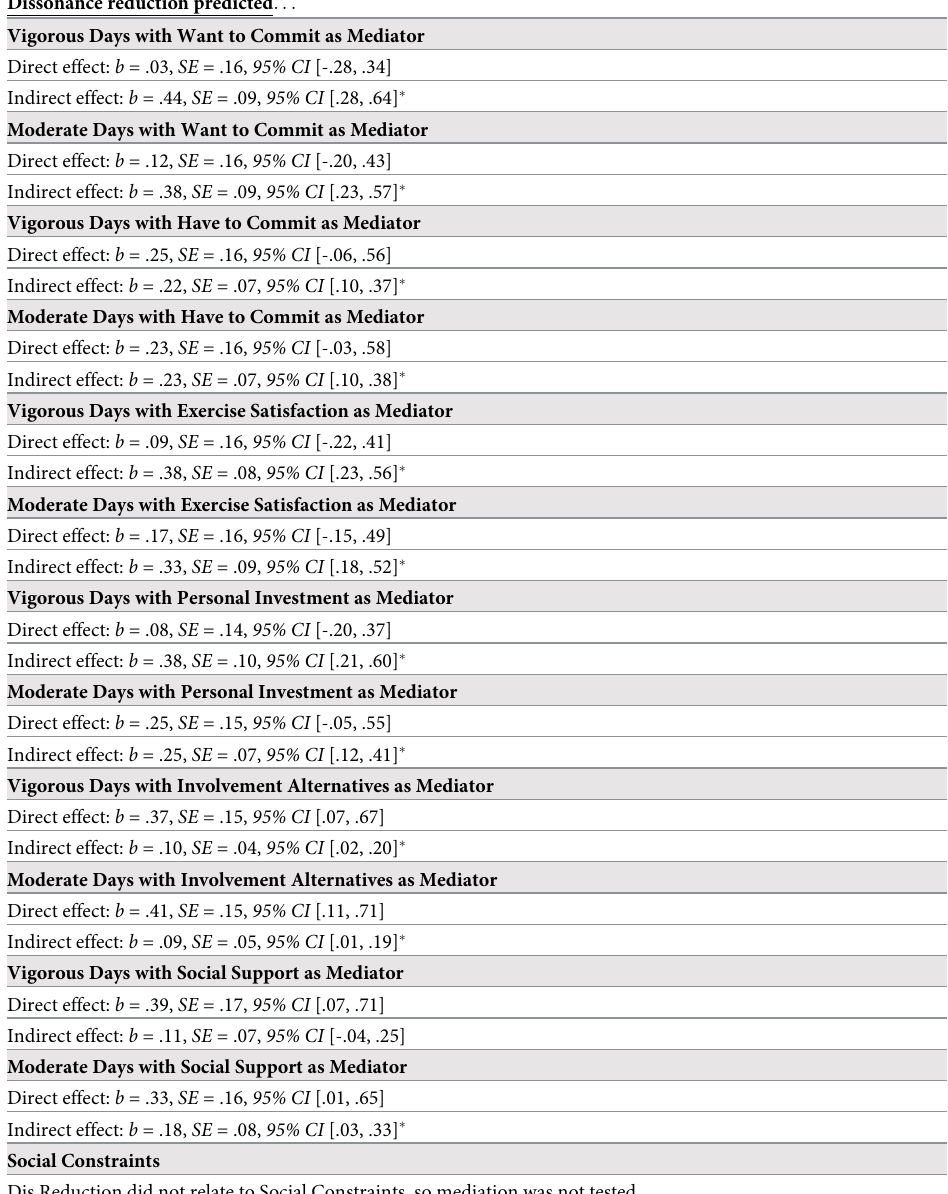
Table 12. Mediational analyses for dissonance reduction and days of exercise (Study 2). Dissonance reduction predicted